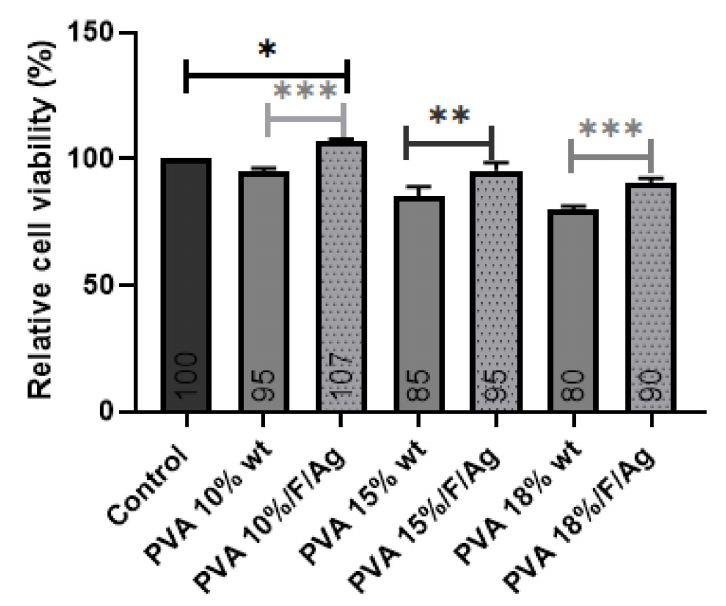
Figure 9. MTS test of percentage of relative MG-63 cell viability for pure PVA and PVA/fibroin/Ag- NPs composite membranes. Statistical analysis was developed with ordinary one-way ANOVA followed by Tukey’s multiple comparisons test, p < 0.05. * Low significant difference, ** Significant difference, *** high significant